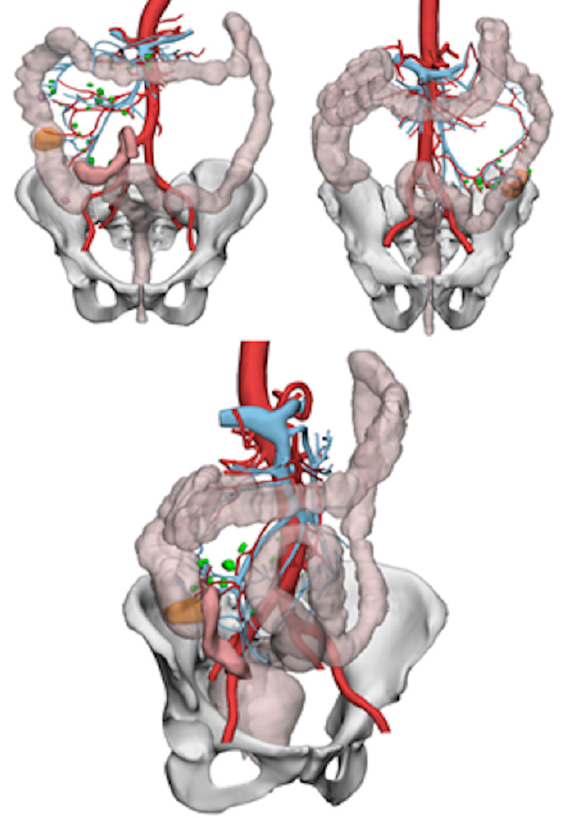
Figure 1. Example of 3D model reconstruction. The 3D models were available in two days. The acquired colonoscopy and CT/MRI scan data used were